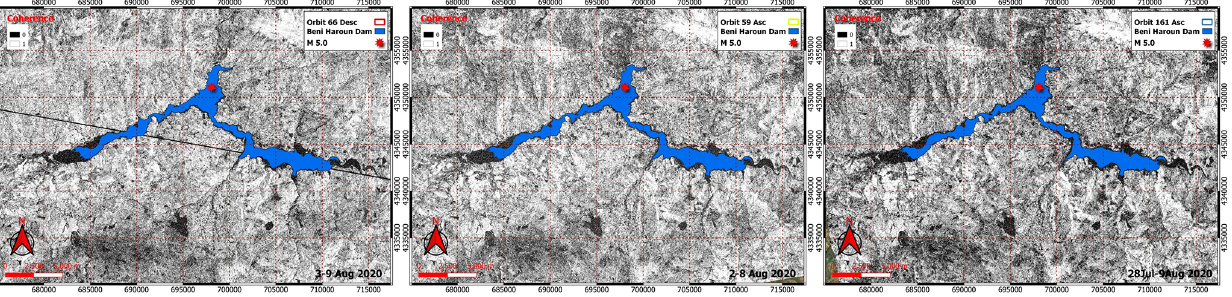
Figure 6. Mila area, InSAR coherence maps for IFG-3 + IFG-4, IFG-17, and IFG-22.